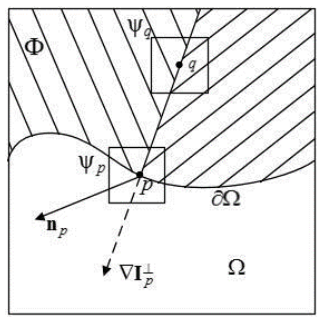
Figure 1 . The traditional mural image restoration